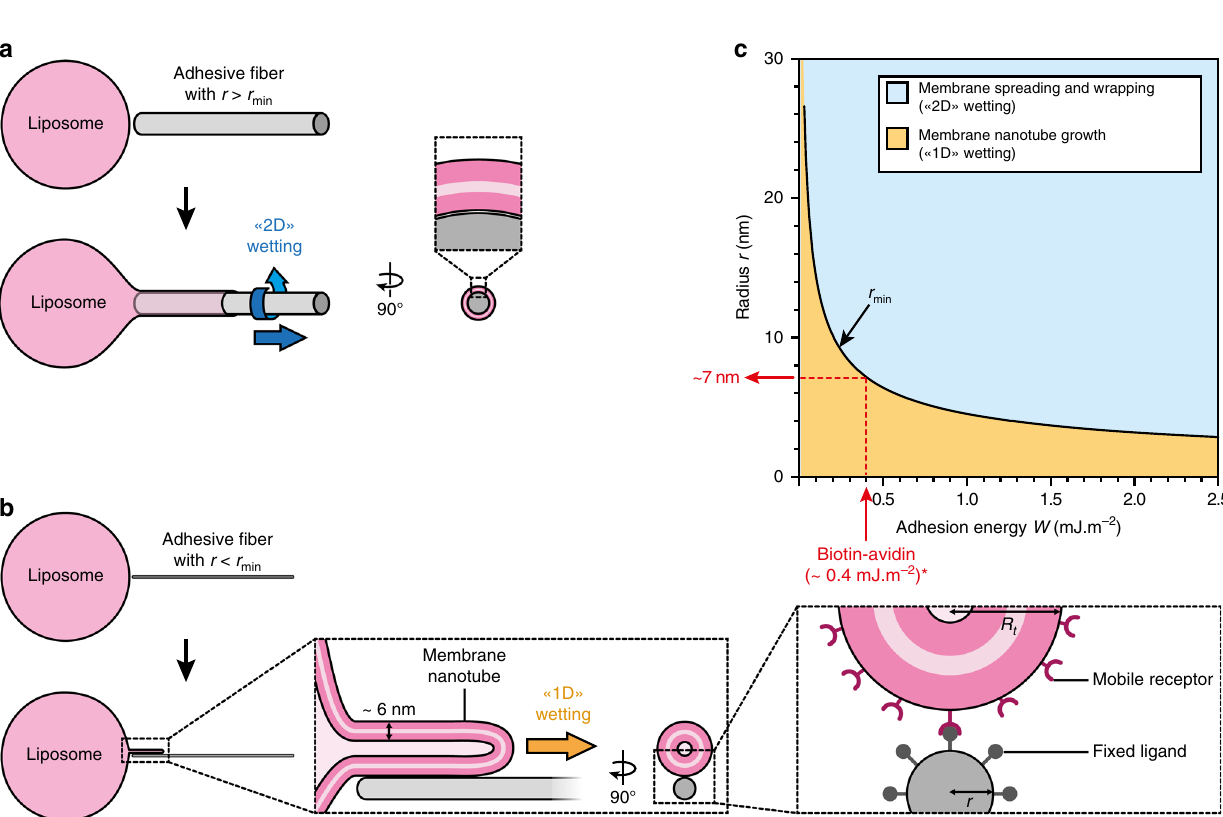
Fig. 3 Theoretical prediction of a novel regime of wetting for the spreading of a liposome on an adhesive nano fi ber. a A liposome spreads on a fi ber of radius r > r min by “ 2D ” membrane wetting, where the bilayer wraps around the fi ber. b On a fi ber of radius r < r min , the liposome cannot wrap the fi ber because of the curvature energy of the bilayer and is predicted to grow a tube of radius R t along the fi ber, which we call “ 1D ” membrane wetting. In the inset most to the right mobile receptors and fi xed ligands are indicated schematically, their size or distribution are not drawn to scale. c Phase diagram of a membrane bilayer spreading on a fi ber versus nano fi ber radius r and adhesion energy W . The black line corresponds to r min separates the “ 2D ” (blue region) and “ 1D ” (yellow region) membrane wetting regimes. (*) Considering a biotinylated actin fi lament decorated with NeutrAvidin and a molar ratio